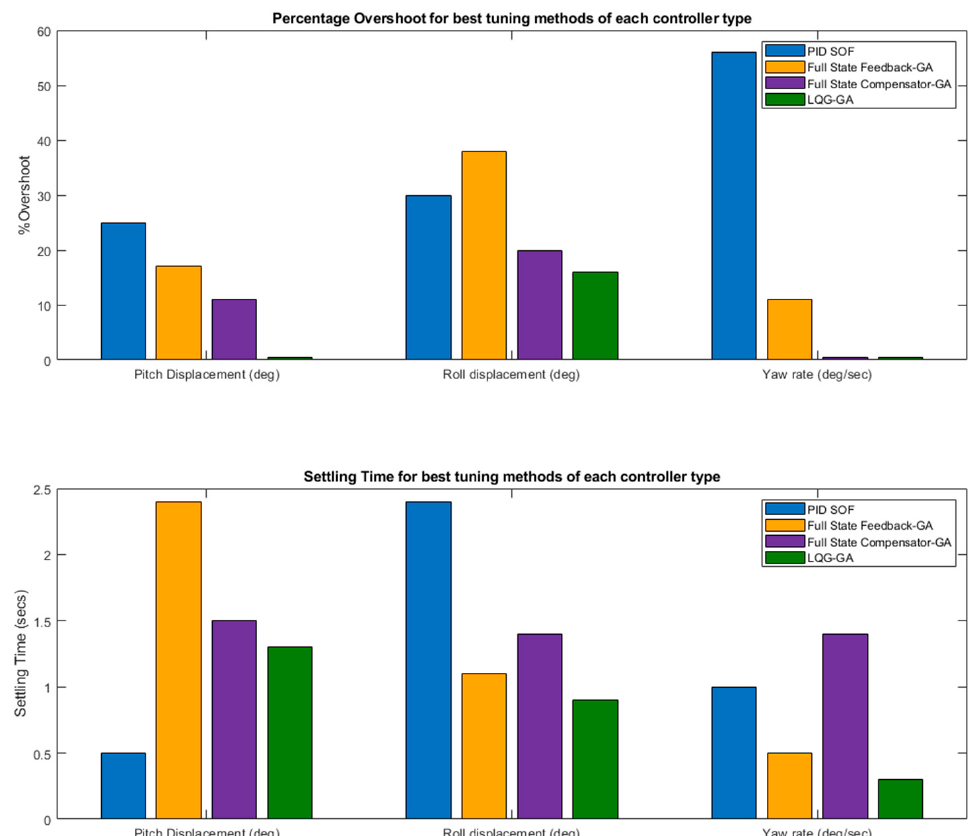
Figure 15. Percentage Overshoot and settling time for best controllers.